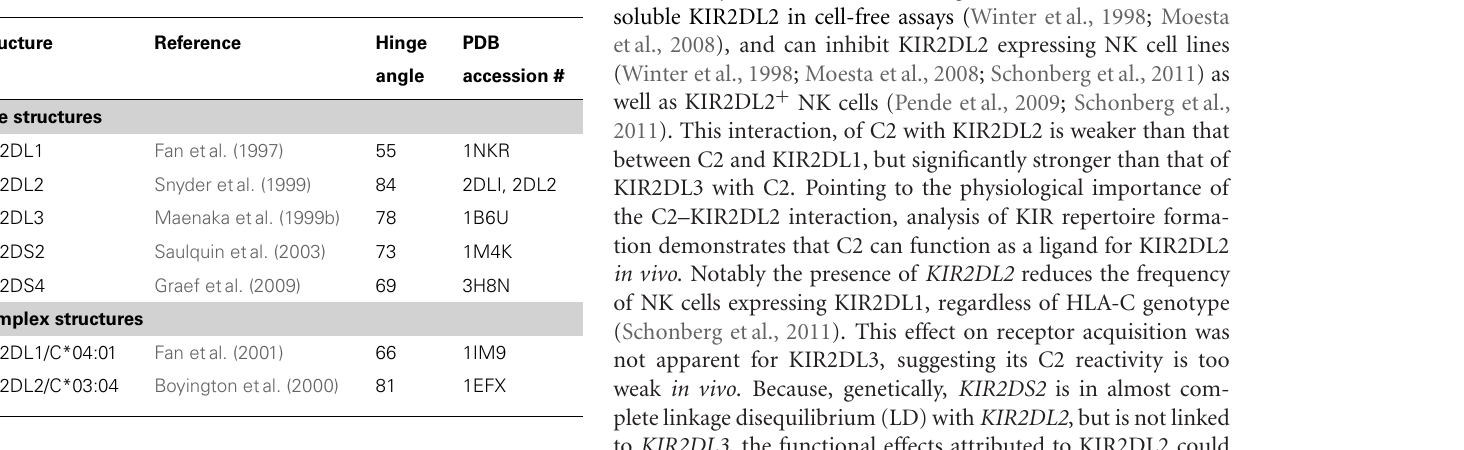
Table 2 | Crystal structures of HLA-C reactive